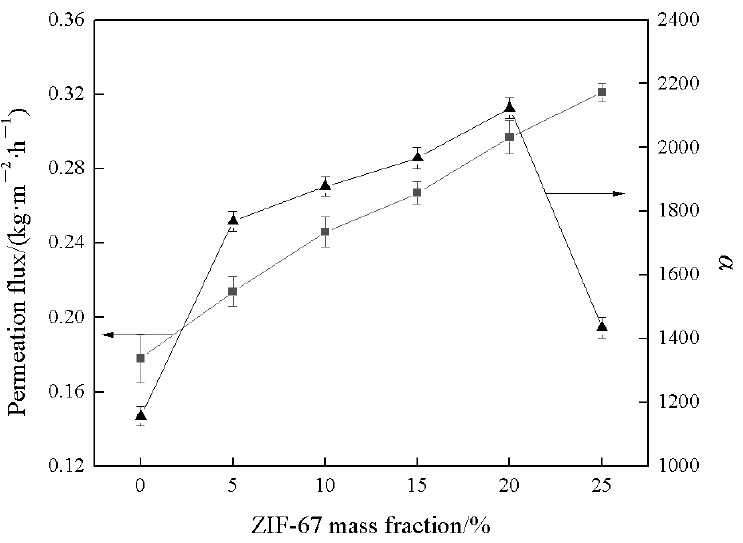
Figure 11. E ff ect of ZIF-67 mass fraction on pervaporation performance of mixed matrix membranes. Figure 11. Effect of ZIF-67 mass fraction on pervaporation performance of mixed matrix